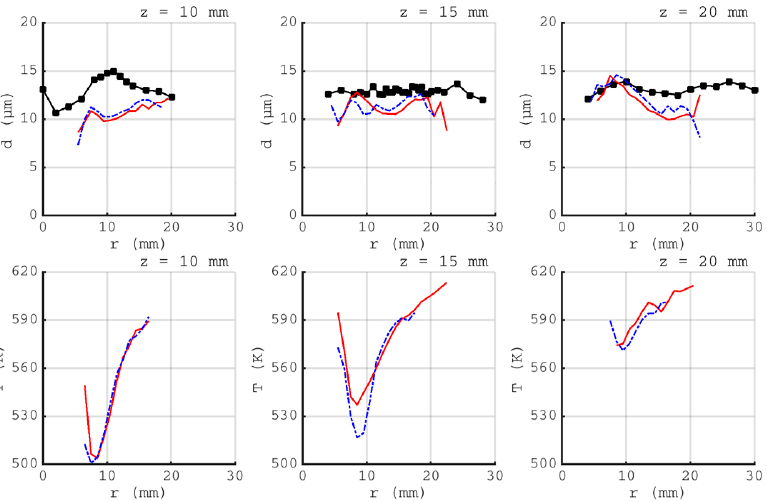
Figure 12. Radial distributions of time-averaged diameter ( top ) and temperature ( bottom ) at three different axial locations. Experimental data from [83]. Legend: experiment (—), Jet A (—), C1 (---).